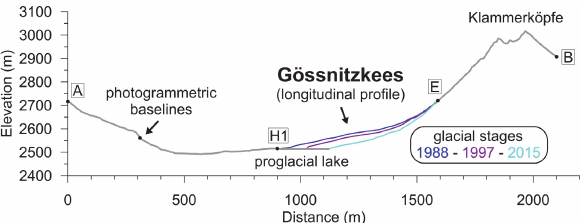
Figure 3. Cross section (profile A-B) showing the glacial stages 1988-1997-2015.